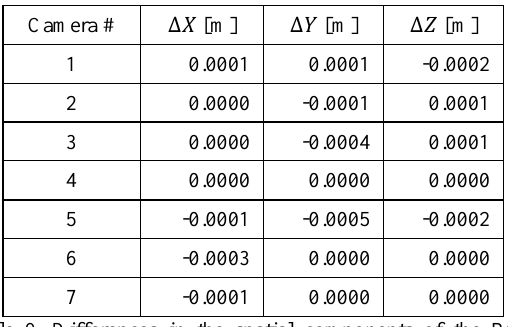
Table 9. Differences in the spatial components of the ROPs